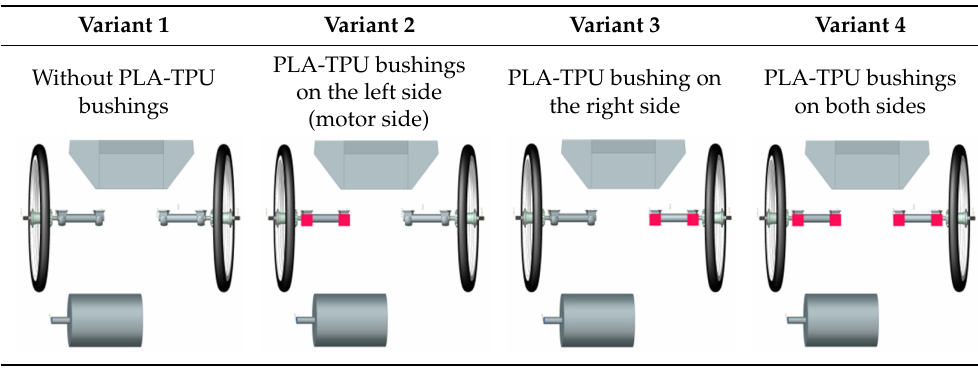
Table 2. Variants of the possible bushing